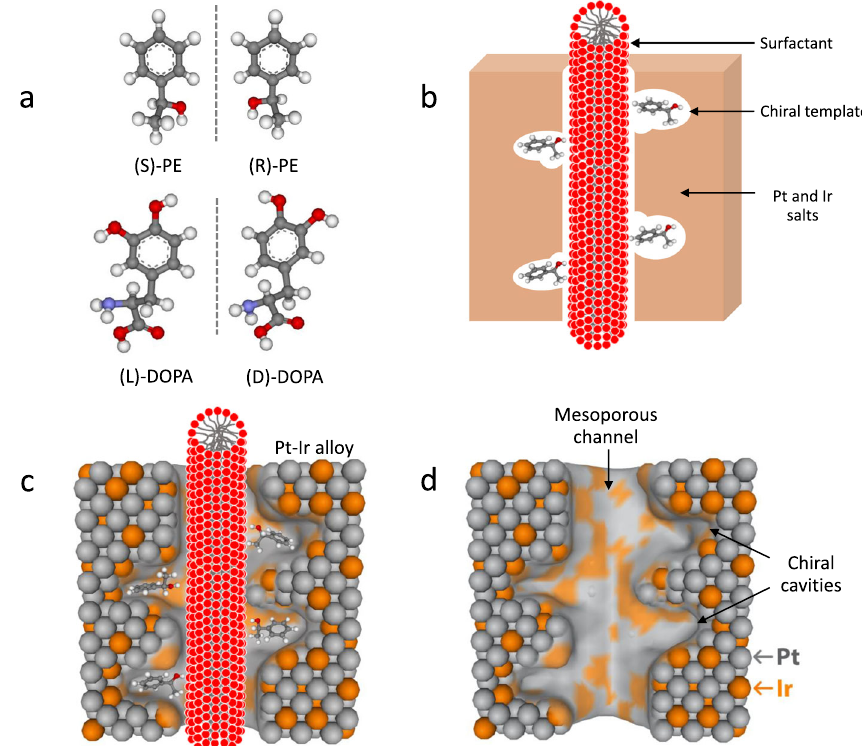
Fig. 1 Synthesis of chiral-imprinted mesoporous Pt-Ir alloys. a Molecular structure of (R)-PE, (S)-PE, (L)-DOPA, and (D)-DOPA. b Formation of columns of non-ionic surfactant decorated with chiral template in the presence of a mixture of Pt and Ir salts. c Growth of alloyed Pt and Ir around the supramolecular surfactant structure and chiral templates by co-electrodeposition. d Final chiral-imprinted mesoporous Pt-Ir alloy after removal of the